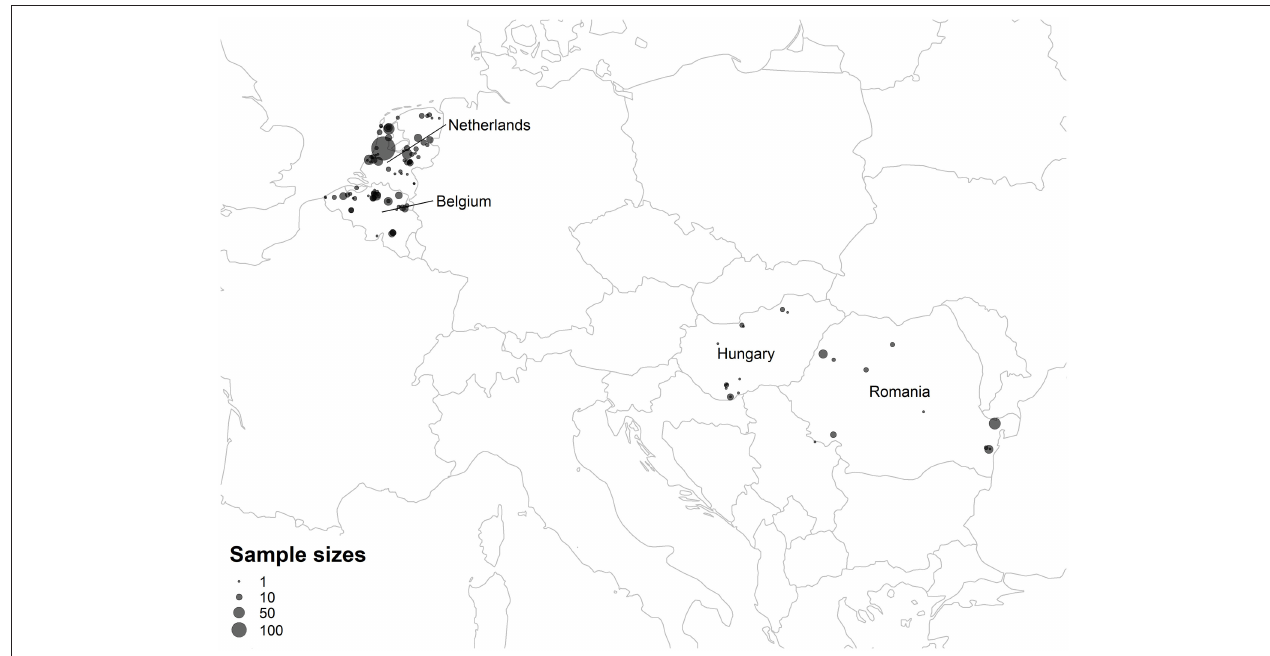
FIGURE 2 | Map of ectoparasite sampling sites. Points summarize the total number of ectoparasite samples from the Netherlands, Belgium, Hungary, and Romania collected from each sampling site. Latitude, longitude, and ectoparasite counts for each sampling site are listed in Table S13 .